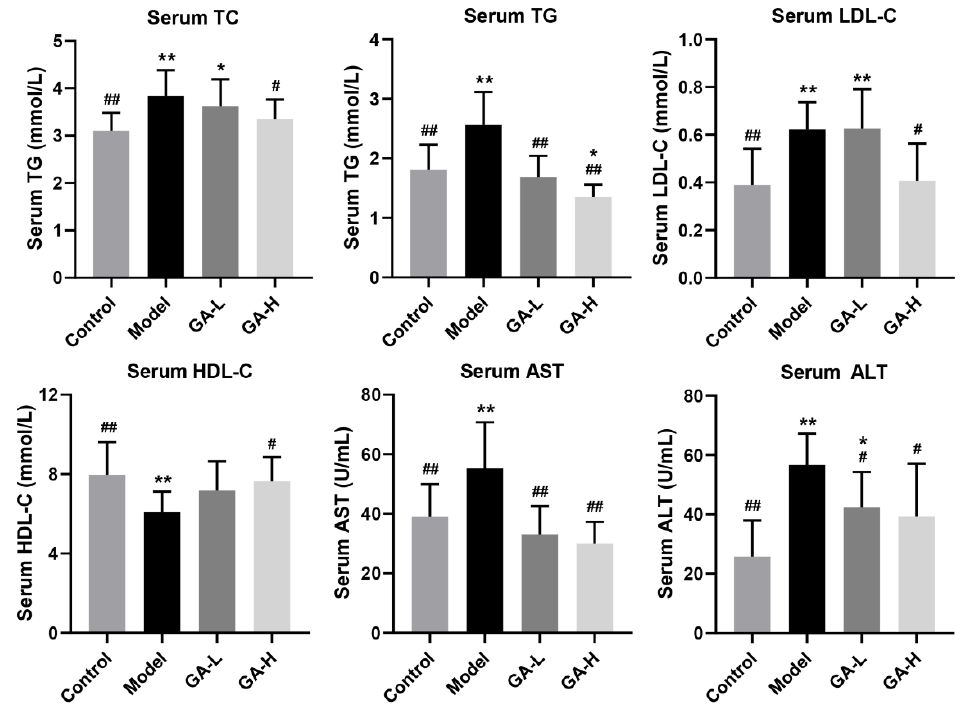
Figure 2. Effects of GA intervention on the serum biochemical parameters (TC, TG, LDL-C, HDL-C, AST and ALT) in mice with excessive alcohol intake. Values were expressed as mean ± SD, and ## p < 0.01 and # p < 0.05, versus the model group; ** p < 0.01 and * p < 0.05, versus the control group.